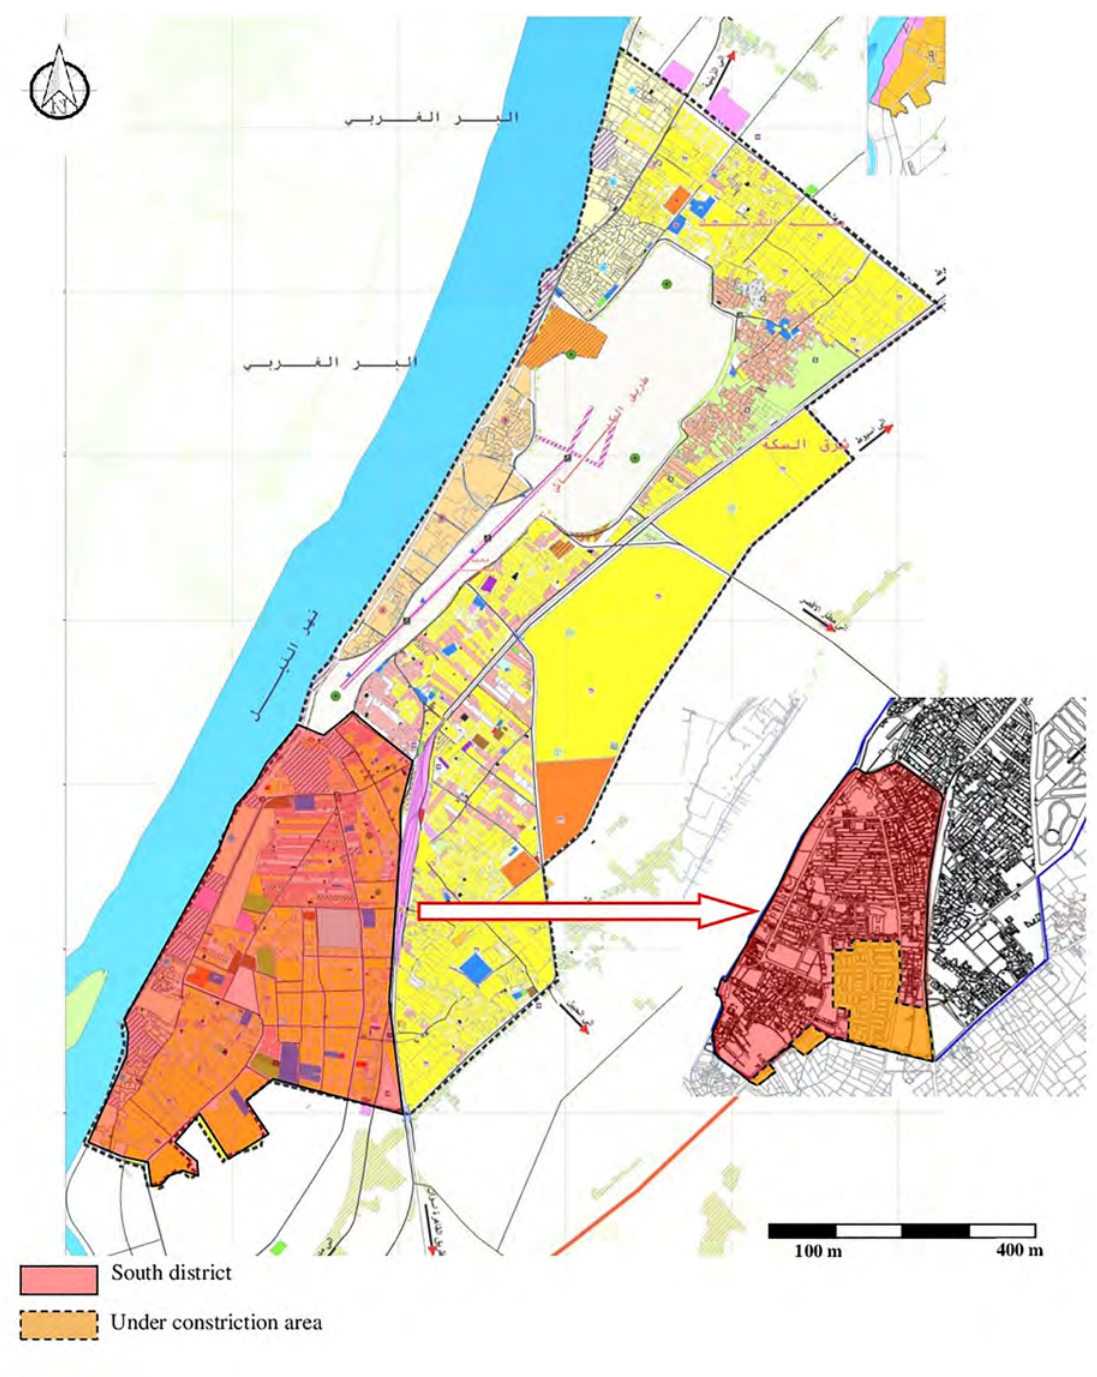
Figure 2. Luxor city map (for Urban Planning (GAUP),